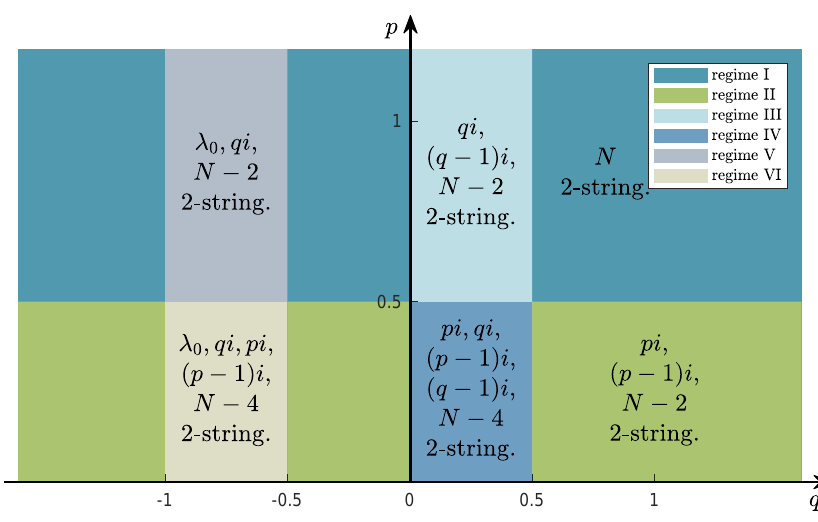
Figure 1: The distribution of reduced Bethe roots at the ground states with different boundary parameters p and q